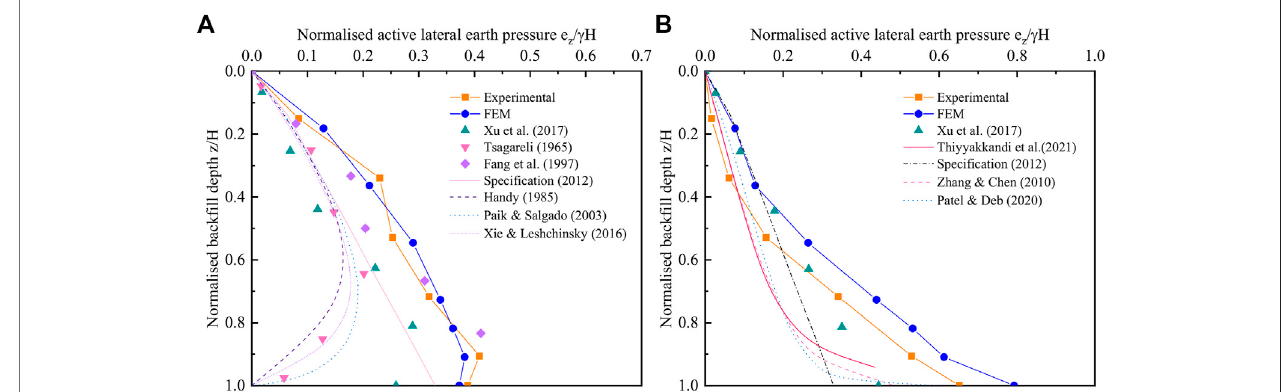
FIGURE 18 | Comparison of active lateral earth pressure ( β = 60 ° ). (A) Tmode. (B) RB mode.